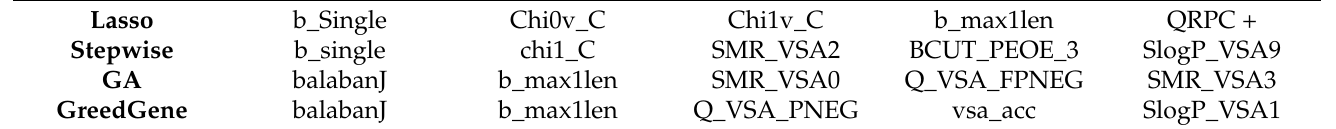
Table 2. Sequence of top five chemical descriptors selected by each algorithm.